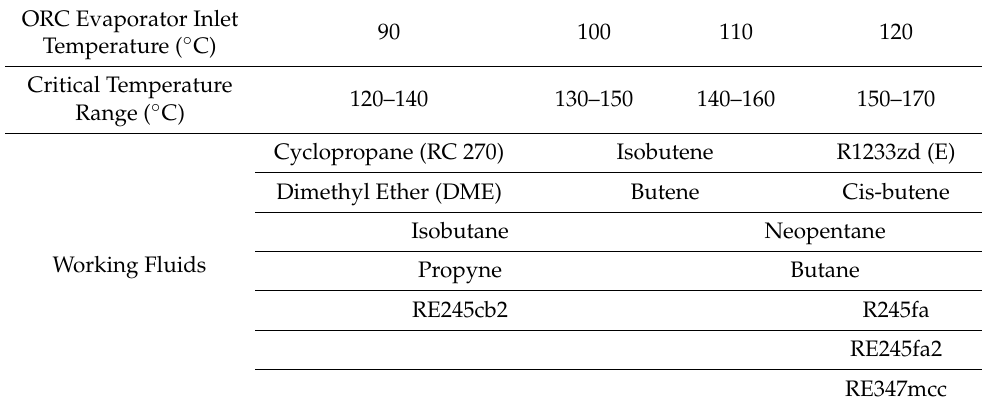
Table 4. Selection of working fluids based on heat source